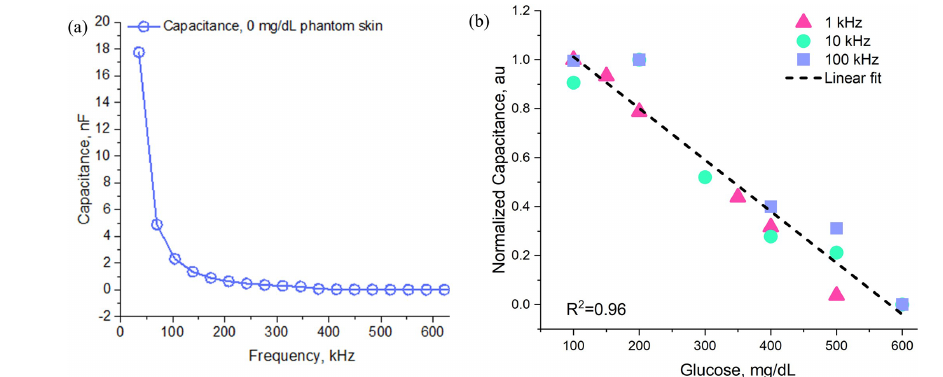
Figure 4. (a) In vitro measurement of blood-mimicking phantoms with varying frequency, (b) normalized capacitance of phantom samples with varying glucose concentration.